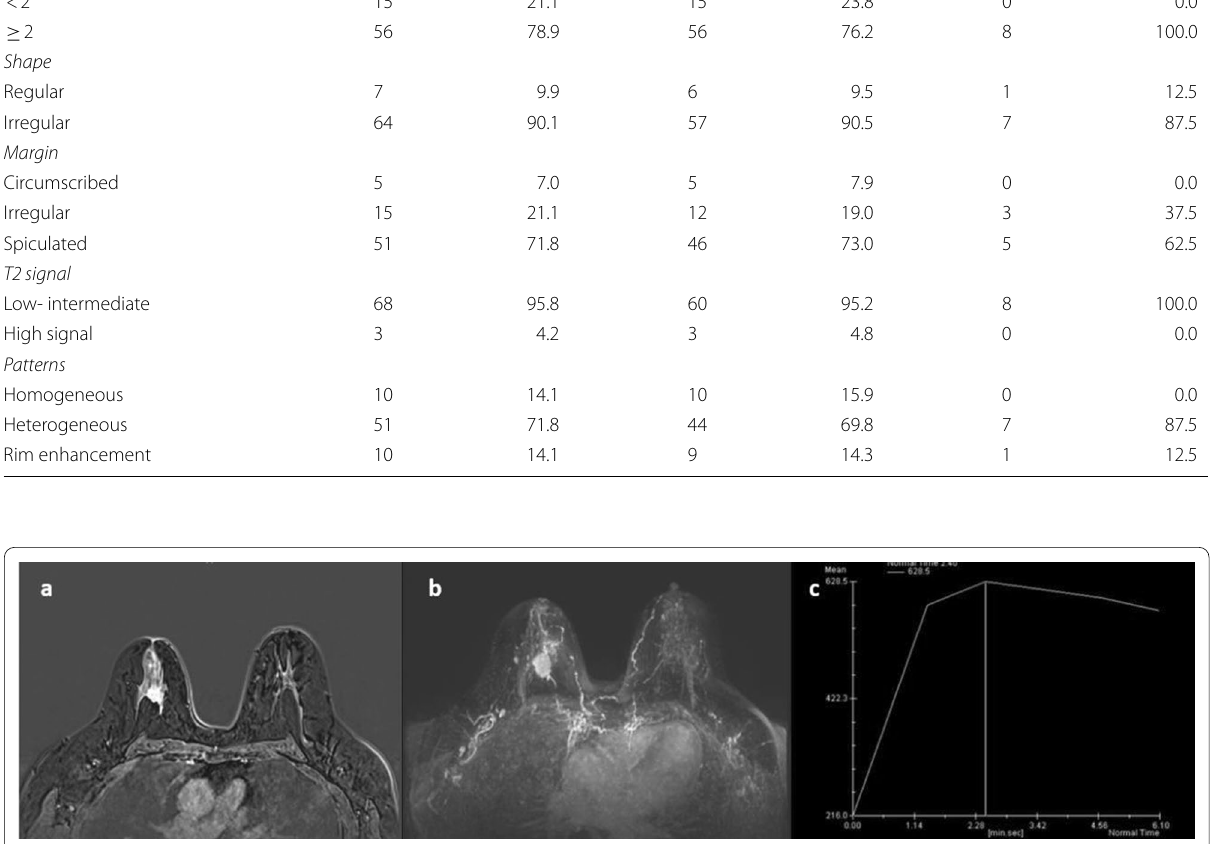
Fig. 2 Rt. Breast pathologically proven invasive ductal carcinoma, NOS, grade III and luminal A type. ITGB 1 FC post‑contrast subtracted images, b MIP images show an irregular, spiculated outlined soft tissue intensity focal mass lesion, seen at the mid‑mammary region, and 12 o’clock area of the Rt. breast, about 37 mm from the nipple, measuring about 24 anterior linear anterior intra‑ ductal extension. It displays intense heterogeneous enhancement at dynamic post‑contrast study. c Type III‑time signal intensity curve. Minimal Rt. sided nippleretraction is seen. Normal MRI appearance of the left